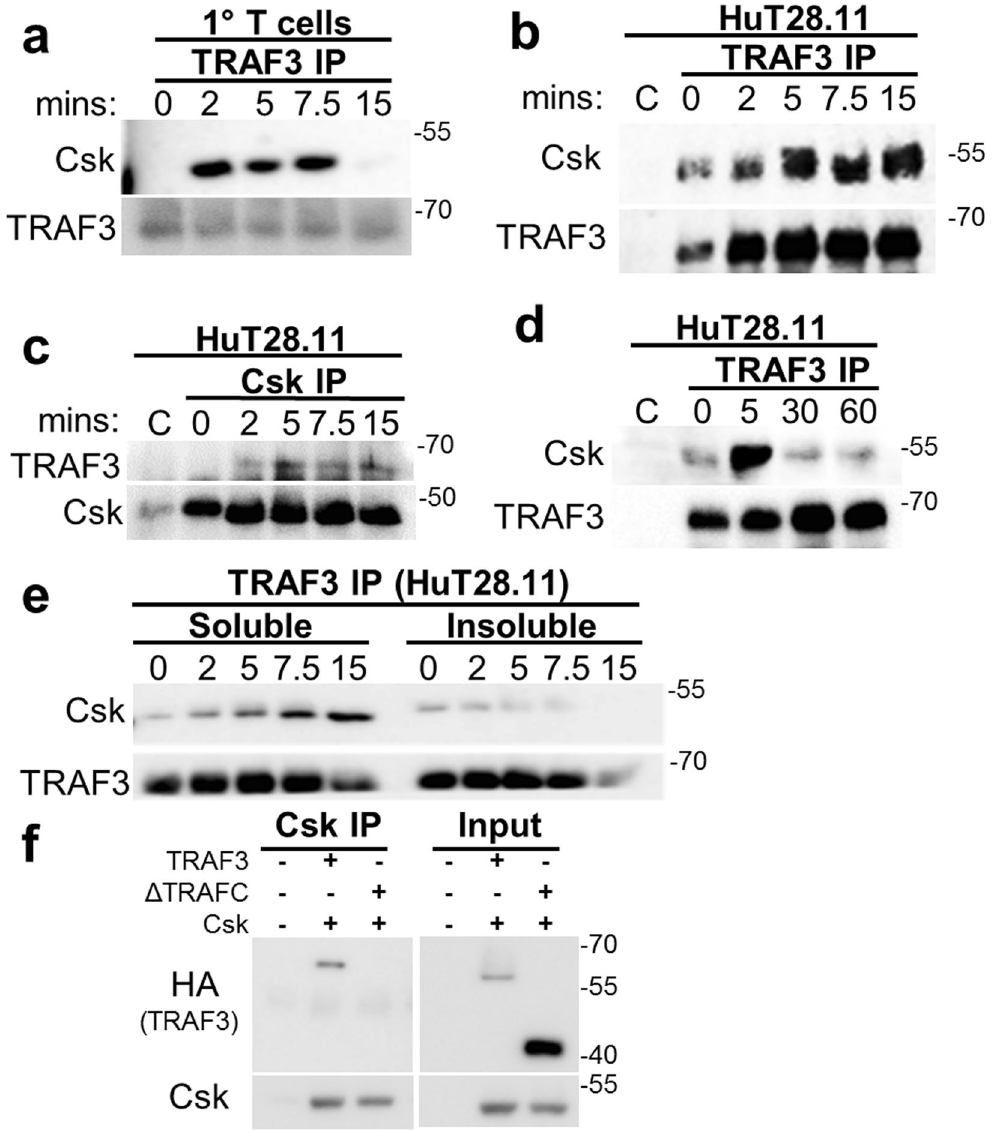
Figure 2. TRAF3 association with Csk in T cells. ( a – d ) T cells were stimulated via CD3/CD28 for the indicated times. Fab fragments targeting the stimulatory antibodies were added to prevent association of the stimulatory antibodies with the magnetic protein G beads. Samples were also precleared to remove any unbound stimulatory antibody. TRAF3 immunoprecipitation was then performed as described in Methods from whole cell lysates of WT primary mouse splenic T cells ( a ) or Hut28.11 T cells ( b and d ). ( c ) Immunoprecipitation of Csk from Hut28.11 whole cell lysates. (e) Cellular fractionation was performed as in Methods on HuT 28.11 T cells. TRAF3 was immunoprecipitated from soluble and insoluble cell lysate fractions, isolated as in Methods. ( a – e ) Analysis by Western blot to detect the indicated proteins. C = Control samples, in which cells were stimulated for 5 ′ and no immunoprecipitation Ab was added, to detect any residual stimulatory Ab association with the protein G beads. ( f ) HEK 293T cells transfected with TRAF3 and Csk constructs (depicted in Fig. 4a) were lysed, and Csk was immunoprecipitated. Total input prior to immunoprecipitation is shown at right. Full- length blots are presented in Suppl. Fig. S5. Data shown are representative of 3–6 independent